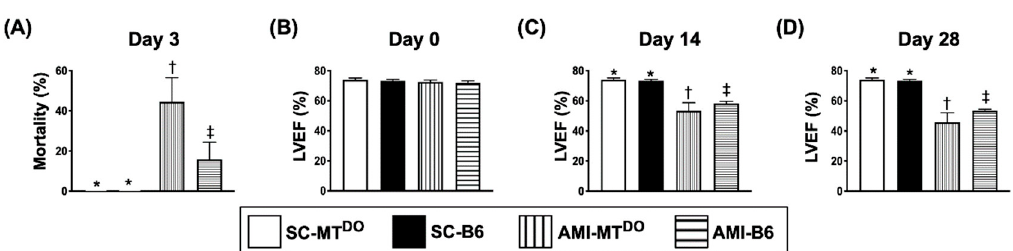
Figure 1. Day-3 mortality rate and left ventricular ejection fraction (LVEF) at days 0, 14 and 28 after acute myocardial infarction (AMI). ( A ) Mortality at day 3 after AMI induction, * vs. other groups with di ff erent symbols (†, ‡), p < 0.01 ( n = 20 for each group). ( B ) LVEF at day 0, p > 0.5. ( C ) LVEF at day 14, * vs. other groups with different symbols (†, ‡), p < 0.001. ( D ) LVEF at day 28, * vs. other groups with di ff erent symbols (†, ‡), p < 0.001. ( n = 6 for each group). All statistical analyses were performed by one-way ANOVA, followed by Bonferroni multiple comparison post hoc test. Symbols (*, †, ‡) indicate significance (at the 0.05 level). SC = sham-operated control; MT DO = double knock out of matrix metalloproteinase (MMP)-9 and tissue plasminogen (tPA) in mouse; B6 (i.e., wild type) = C57BL/6 mice.